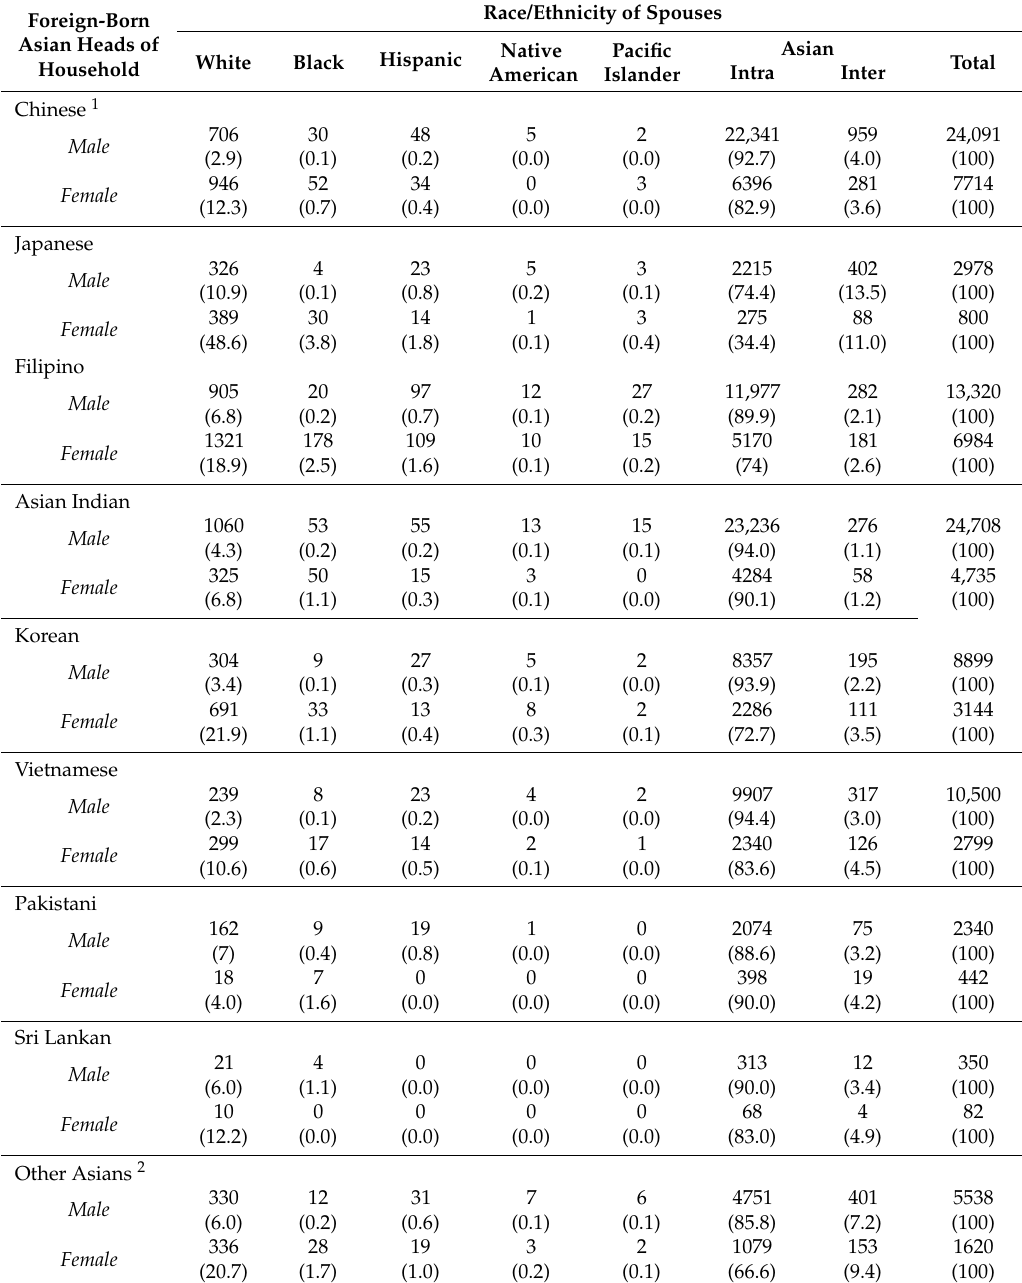
Table 5. Intermarriage Patterns of Foreign-Born Asian Household Heads by Sex and by Race or Ethnicity of Spouses, ACS